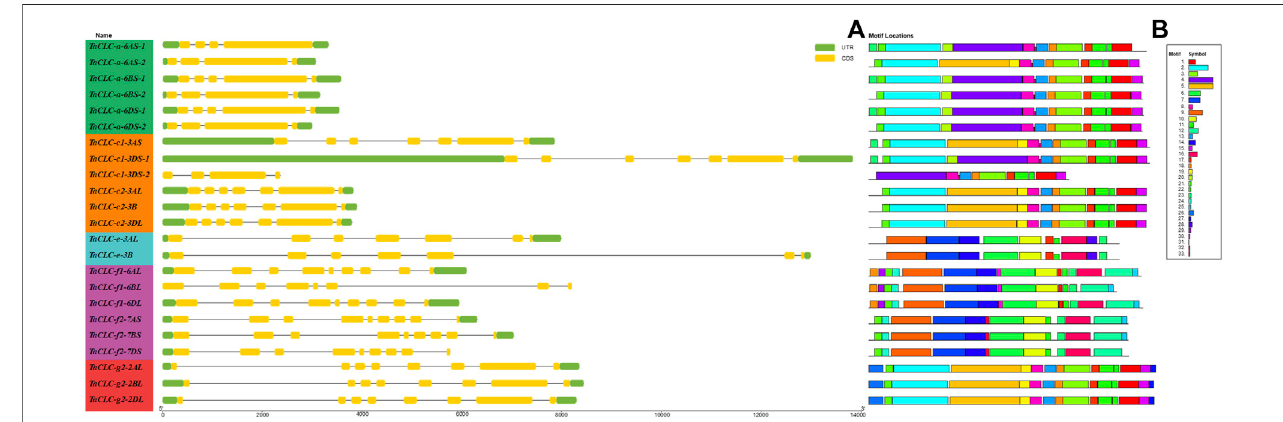
FIGURE5| Genestructureandconservationmotifsof TaCLC gene. (A) Genestructure. TaCLC genesaredisplayedintheorderbasedonphylogeneticanalysisof their proteins. Introns, exons and noncoding regions are represented with black lines, yellow boxes and green boxes, respectively. (B) Conserved motifs of TaCLC proteins. Thirty three motifs were identi fi ed and are marked with different colors.